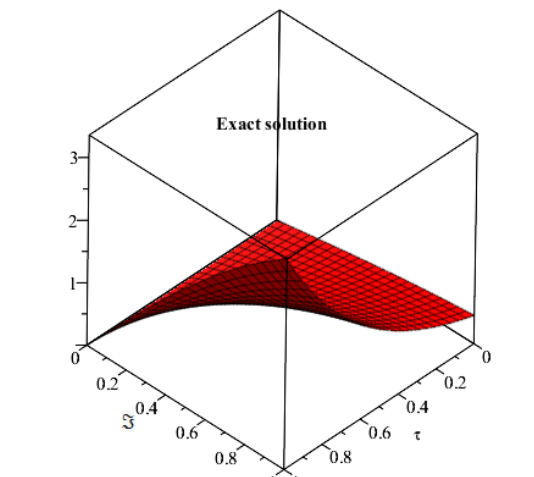
Figure 9. Exact solution of Example 3 at β =